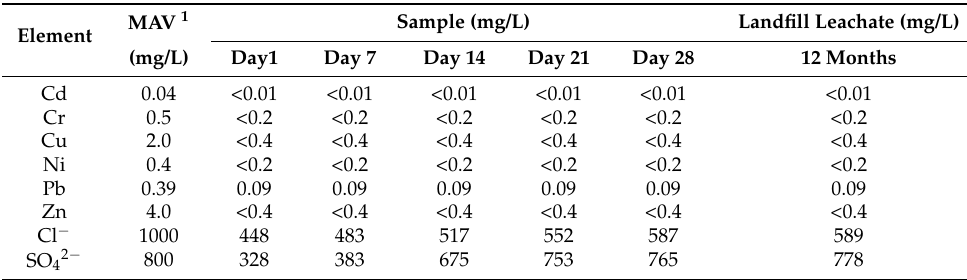
Table 2. Pollutant species